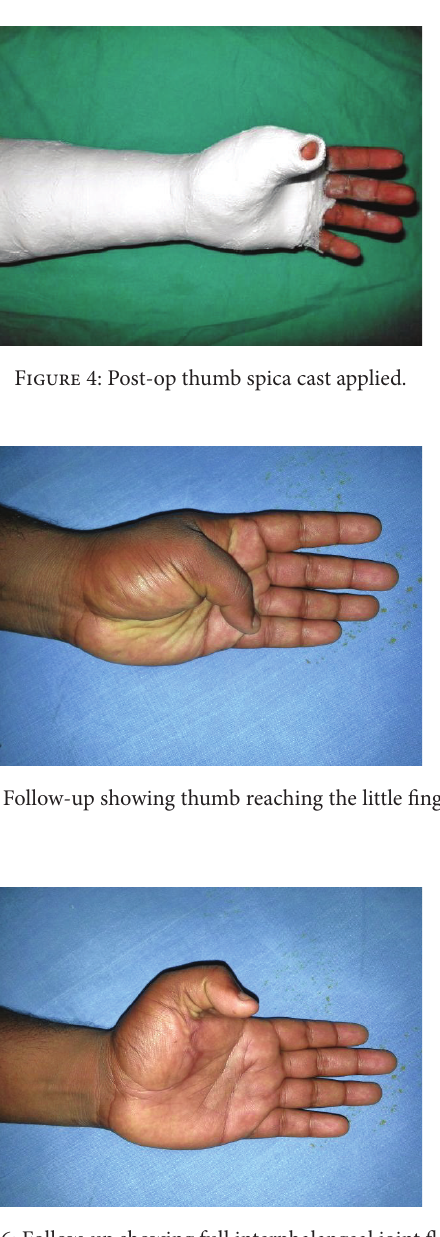
Figure 6: Follow-up showing full interphalangeal joint flexion.